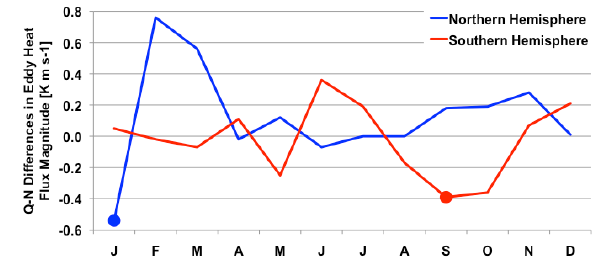
549 Figure 11 : Q – N differences in eddy heat flux magnitude at 40°–80° latitude, 100 hPa 550 Fig. 11. Q − N differences in eddy heat flux magnitude at 40 ◦ –80 ◦ in the Northern Hemisphere (blue line) and Southern Hemisphere (red line). Negative 551 latitude, 100hPa in the Northern Hemisphere (blue line) and South- differences indicate a relative reduction in tropospheric planetary wave driving. The 552 ern Hemisphere (red line). Negative differences indicate a relative case shown in Figure 10 is highlighted by the red circle. The case shown in Figure 12 is 553 reduction in tropospheric planetary wave driving. The case shown highlighted by the blue circle. 554 in Fig. 10 is highlighted by the red circle. The case shown in Fig. 12 is highlighted by the blue